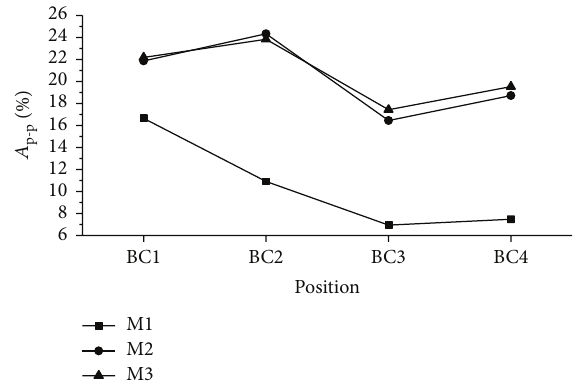
Figure 12: Peak-peak amplitudes at the points in the back sidewall gap.